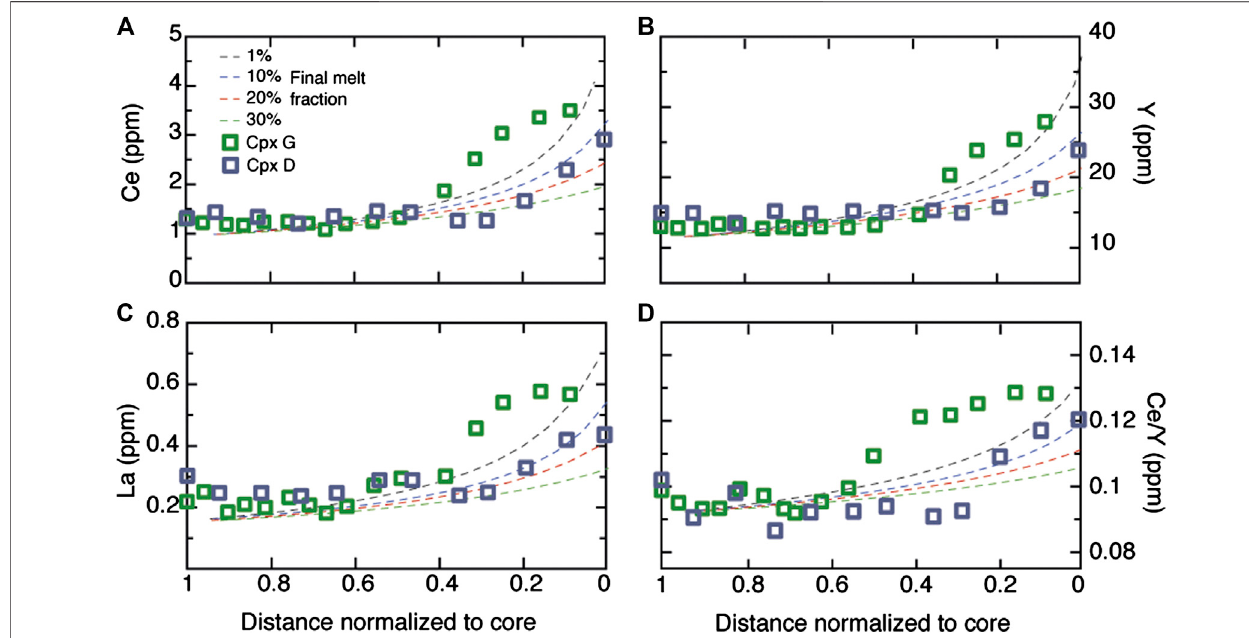
FIGURE6 | Variation ofCe, La and Y (ppm) and Ce/Y ratio ofa clinopyroxenefrom a ol-gabbros crystallized by afractional crystallization process are compared to thoseofclinopyroxeneinareaG.Distanceisnormalizedtocore.Thedifferentmodelsrefertodifferentfractionalcrystallizationprocessscenariosatresidualmeltfractions varying from 1 to 30%as indicated inthe legend.Initial melt is in chemical equilibrium with clinopyroxene core; partition coef fi cients for La, Ce and Y are calculated using the model of Sun and Liang (2012; 2017) at T ∼ 1180 ° C and are 0.090, 0.154 and 0.598 for clinopyroxene; 0.095, 0.085 and 0.017 for plagioclase and 0.0003, 0.0004 and 0.004 for